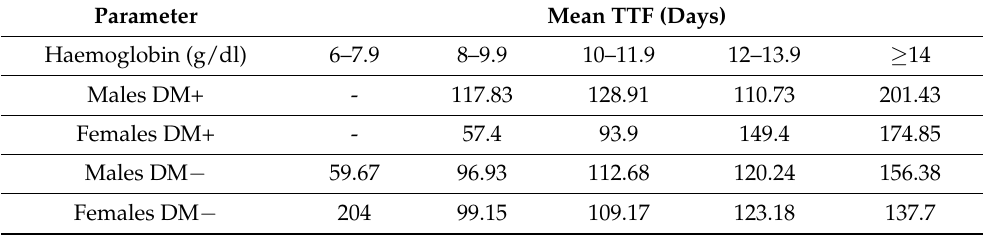
Table 6. Average TTF by sex, DM status, and haemoglobin value.